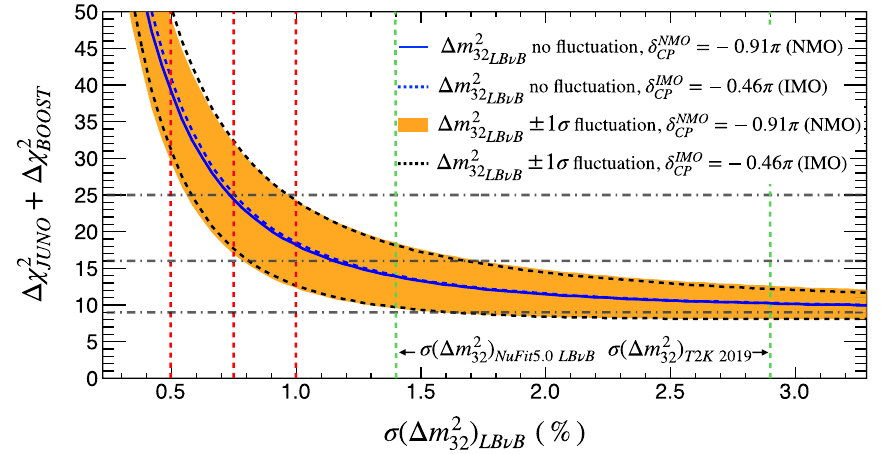
Figure 5. JUNO mass ordering sensitivity boosting. A significant increase of JUNO intrinsic sensitivity ( �χ 2 JUNO ≈ 9 ) is possible exploiting the LB ν B’s disappearance (DC) characterised by �χ 2 BOOST depending strongly on the uncertainty of (cid:31) m 2 32 . Today’s NuFit5.0 average LB ν B-II’s precision on (cid:31) m 2 32 is ∼ 1.4% . A rather humble 1.0% precision is possible, consistent with doubling the statistics if systematics allowed. Since NOvA and T2K are expected to increase their exposures by about factors of ∼ 3 before the shutdown, sub-percent precision may also be within reach. While the ultimate precision is unknown, we shall consider a ≥ 0.75% precision to illustrate this possibility. So, JUNO alone (intrinsic + boosting) could yield a ≥ 4 σ (i.e., �χ 2 ≥ 16) MO sensitivity, at ≥ 84% probability, within the LB ν B-II era. A 5 σ potential may not be impossible, depending on fluctuations. Similarly, JUNO may further increase in significance to resolve ( ≥ 5 σ or �χ 2 ≥ 25 ) a pure vacuum oscillations MO measurement in combination with the LB ν B-III’s (cid:31) m 2 32